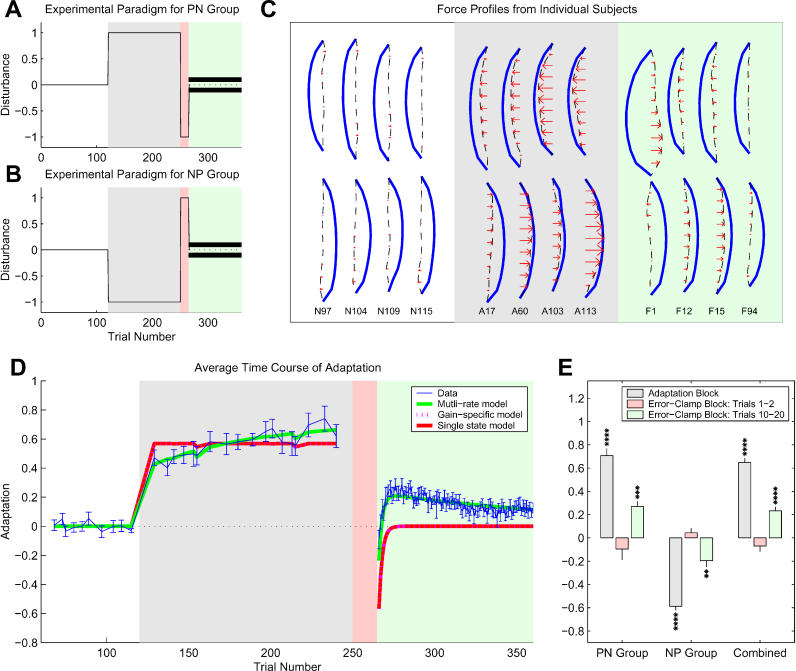
Experimental Results from the Force-Field Learning Error-Clamp Paradigm(A and B) Paradigms for simulated error-clamp experiment. These paradigms are the same as the paradigm shown in
Figure 2A, except that here one group (the NP group) of participants is exposed to an initial adaptation to a clockwise viscous-curl force field while the other group (the PN group) is exposed to an initial adaptation in the opposite direction (counterclockwise).
(C) Example force trajectories during the course of this learning paradigm. Force trajectories from selected error-clamp trials for one participant in each group are shown as red arrows with tips connected by dashed black lines. The blue line represents the force trajectory required to fully cancel the force field applied during the initial learning block for each participant. The same trials are shown for each participant, and each trial is labeled by a block identifier and the trial number within that block. For example, N97 is the 97th trial in the null-field practice block, A17 is the 17th trial in the initial adaptation block, and F1 is the first trial in the force-channel (error-clamp) block. Since the adaptation requires the production of lateral forces, only lateral forces are shown. Lateral forces (red arrows) in the baseline period are small and inconsistent in direction. However, during the initial adaptation block these lateral forces grow with training so that they nearly cancel the applied force field. After the extinction block, the first trials in the error-clamp block show a near-zero or negative pattern of lateral forces with respect to the forces displayed late in the initial adaptation block. However, by trials 12–15 in the error-clamp block, a small but consistent rebound of the pattern of lateral forces seen during initial adaptation emerges. This rebound substantially fades away by trial 90 in the error-clamp block.(D) The average time course of adaptive changes in the pattern of lateral forces. Data from both the PN and NP groups are averaged together. The adaptation score corresponding to the force pattern displayed on a particular trial was assessed by computing a force-field compensation factor (see
Materials and Methods). In short, this force-field compensation factor measures the fraction of (initial adaptation) force field that would be compensated by the pattern of lateral forces displayed on a particular trial by regressing the measured lateral force pattern onto the ideal pattern of lateral forces required to fully compensate the force field. The transient rebound of motor output in the error-clamp block matches the rebound predicted by the multi-rate model. The blue error bars represent experimental data (mean +/− standard error of the mean.). The green line is the best-fit multi-rate model, and the red and purple lines are the best-fit gain-specific and single-state models. The best-fit model parameters (with 95% confidence intervals) for the multi-rate model were A
1 = 0.992 (0.990–0.994), B
1 = 0.02 (0.013–0.025), A
2 = 0.59 (0.43–0.76), and B
2 = 0.21 (0.10–0.35).
(E) Summary of results from NP and PN groups. The asterisks indicate significant difference in lateral forces from baseline. Both groups display significant adaptation rebound by trials 10–20 of the error-clamp block compared to the initial error-clamp trials (
p < 0.01 for both the NP and PN groups taken separately, and
p < 0.0001 for all participants taken together) and compared to baseline lateral force levels before learning (
p < 0.01 for the NP group,
p < 0.001 for the PN group, and
p < 0.0001 for all participants taken together).
NP, negative/positive group; PN, positive/negative group.